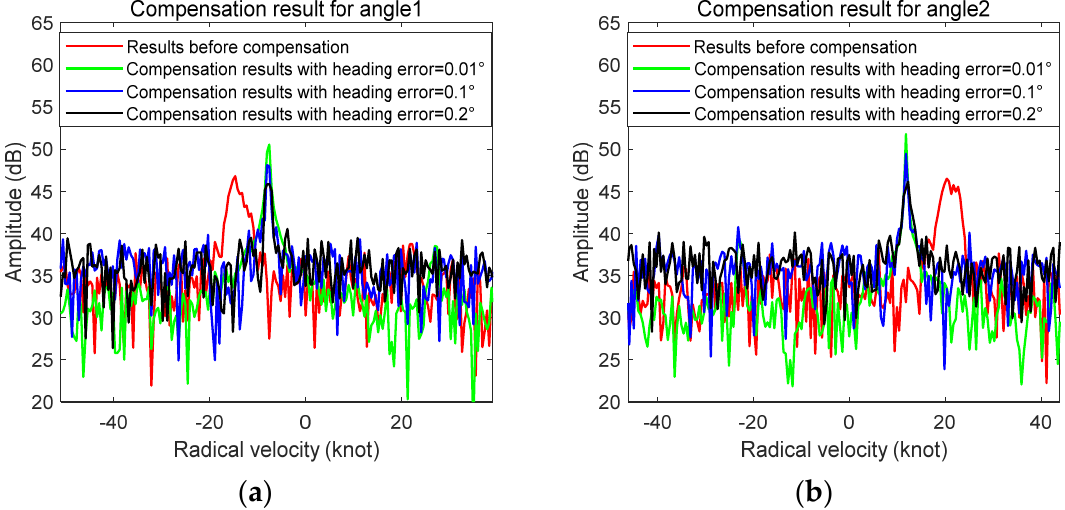
Figure 22. Motion compensation results under different heading measurement error: ( a ) compensation result for angle1, ( b ) compensation result for angle2.